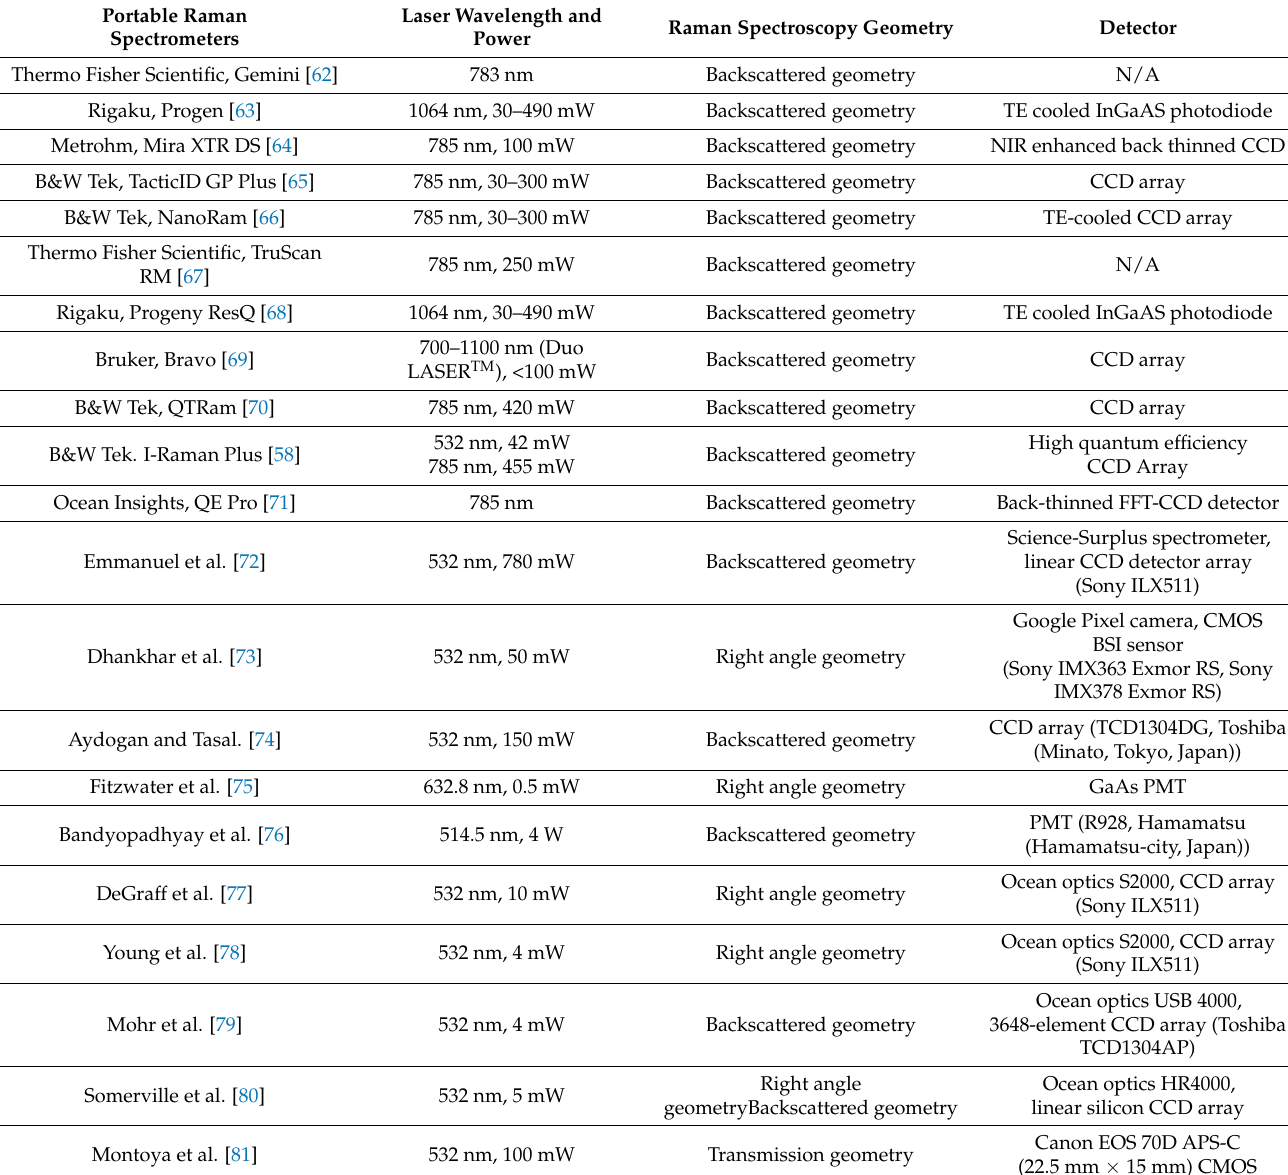
Table 1. Laser, detector, and configuration of handheld Raman spectrometers. Handheld Raman spectrometers. Commercially available Raman spectrometers from Thermo Fisher Scientific (Waltham, Massachusetts, USA) [62], Rigaku (Tokyo, Japan) [63], Metrohm (Herisau, Switzerland) [64], B&W Tek (Newark, DE, USA) [65], B&W Tek (Newark, DE, USA) [66], Thermo Fisher Scientific (Waltham, Massachusetts, USA) [67], Rigaku (Tokyo, Japan) [68], Bruker (Billerica, Massachusetts, USA) [69], B&W Tek (Newark, DE, USA) [70], B&W Tek (Newark, DE, USA) [58], and Ocean Insights